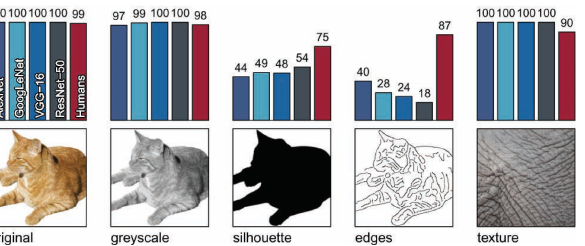
Figure 4. Reference [24] showed that Convolutional Neural Networks focus more on texture than on shapes and that it is a good idea to improve shape bias to obtain more reliable results in the way humans would interpret the content of an